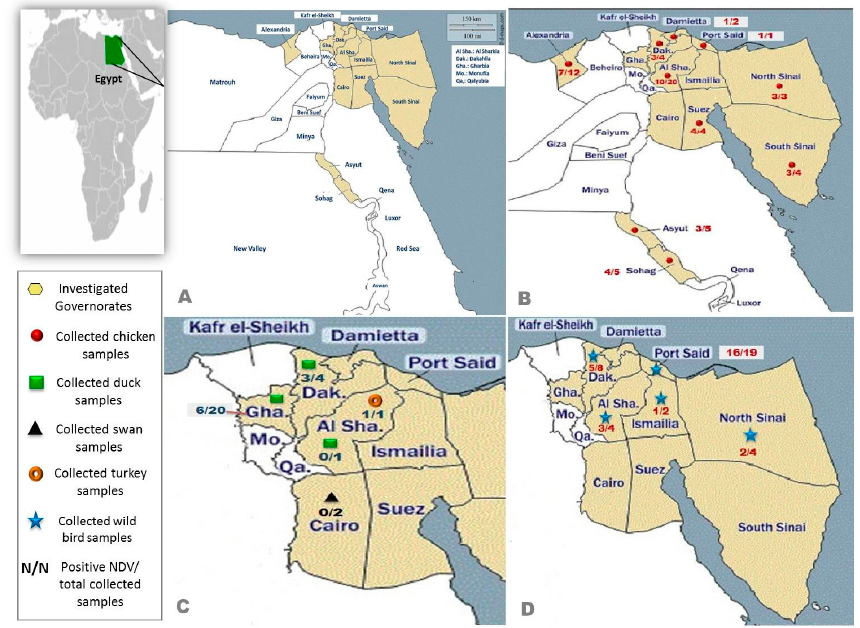
8 of 17 Figure 2. Wild bird breeds in Egypt positive for NDV as single natural infection (detected via NDV F gene-specific RT-PCR, blue bars) or mixed natural infection with NDV and AIV (detected by Flu- M gene-specific RT-PCR, maroon bars). The numbers of birds negative for NDV are indicated as green bars. 3.3. Incidence of NDV Based on F Gene The isolation of NDV in the different governorates (n = 13) of Egypt and the case